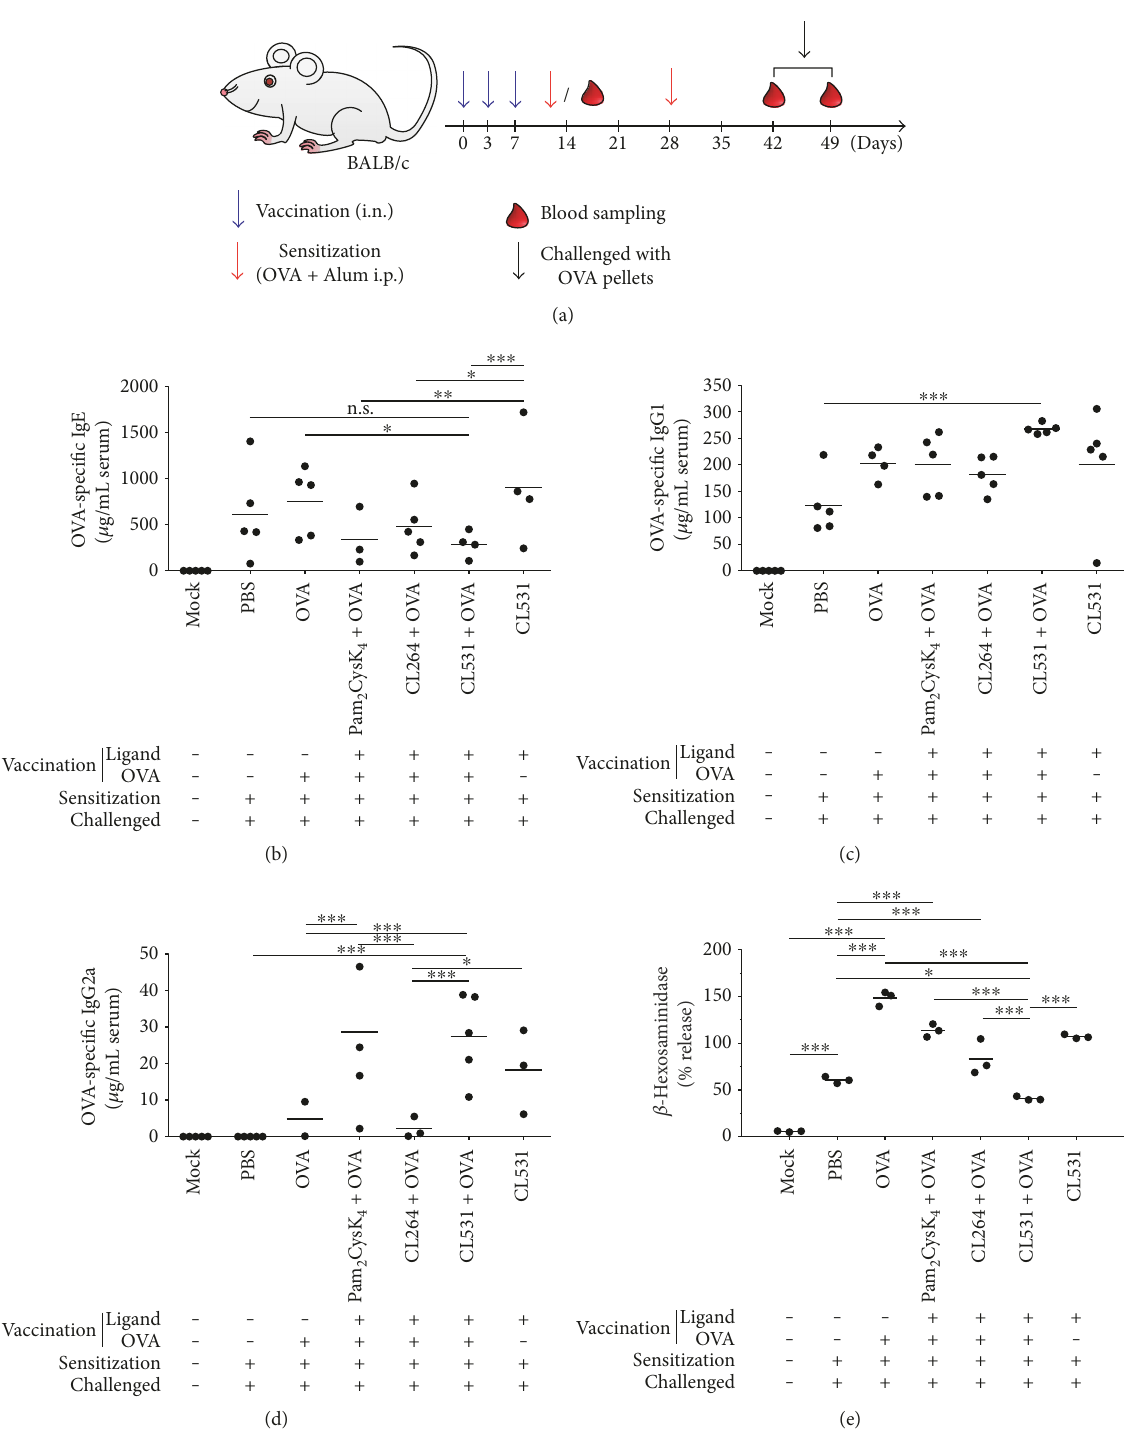
Figure 5: Prophylactic vaccination with CL531 plus OVA suppresses OVA-speci fi c IgE production while inducing OVA-speci fi c IgG production in a mouse model of OVA-induced intestinal allergy. Schematic representation of prophylactic vaccination approach (a). Blue arrows represent intranasal (i.n.) vaccination or mock vaccination (in “ Mock ” group); red arrows represent intraperitoneal (i.p.) sensitization with 10 μ g OVA with 2mg Alum in 200 μ L sterile PBS (or, in “ Mock ” group, with sterile PBS alone). Blood drops represent blood sampling from the tail after vaccination and sensitization or cardiac puncture after challenged with OVA-containing food pellets. Serum concentration of OVA-speci fi c IgE (b), IgG2a (c), and IgG1 antibodies (d) was measured throughout the vaccination experiment by ELISA. β -Hexosaminidase release from RBL 2H3 cells upon crosslinking with OVA was performed with pooled sera from the fi nal bleeding (e). Results are means ± SD from fi ve mice per group (b, c, d) or means of three technical replicates measured using the same serum pool to sensitize the RBL 2H3 cells (e). ∗ P < 0 05 ; ∗∗ P < 0 01 ; ∗∗∗ P < 0 001